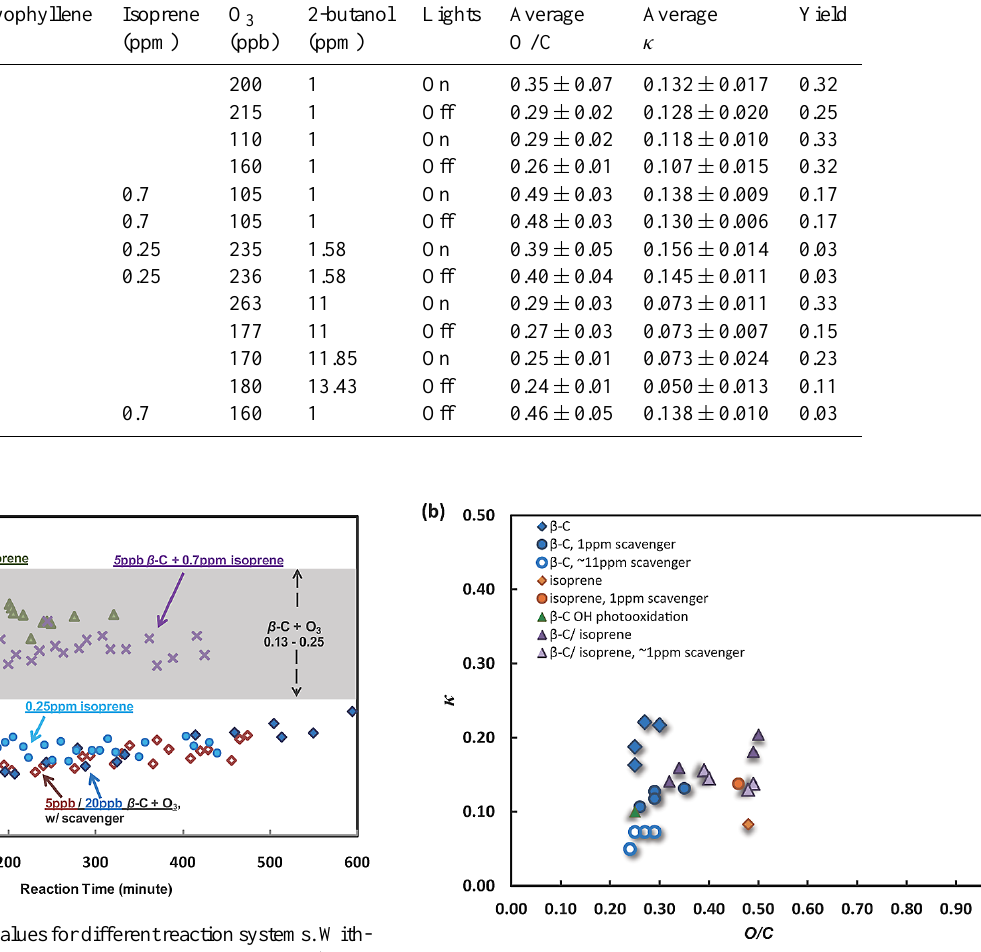
Fig. 4b. Plot of average κ versus O/C using data in Tables 1 and